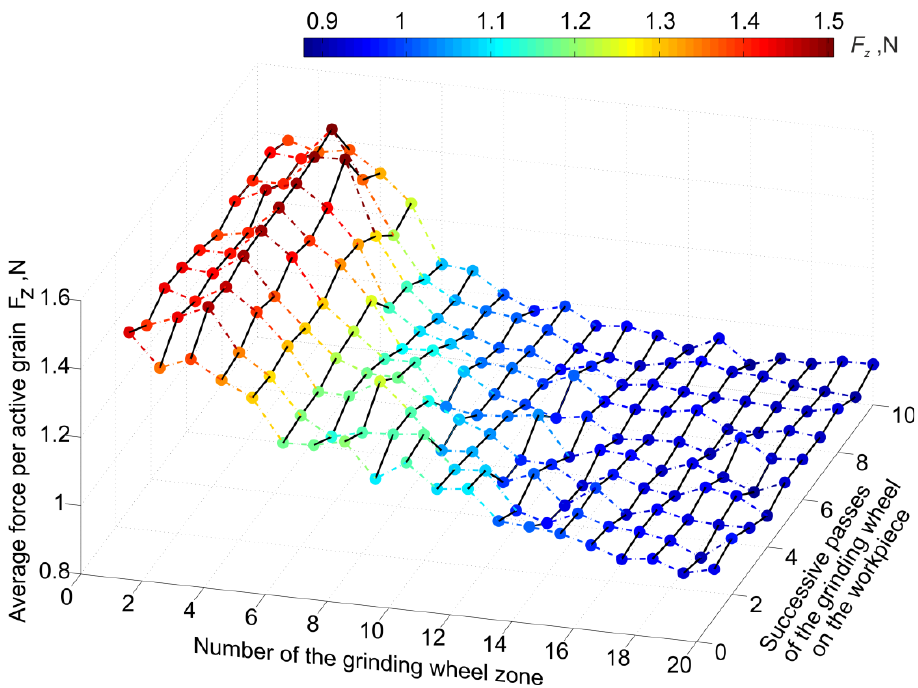
Figure 7. Average force per active grain depending on the zone number on the grinding wheel sur- face .